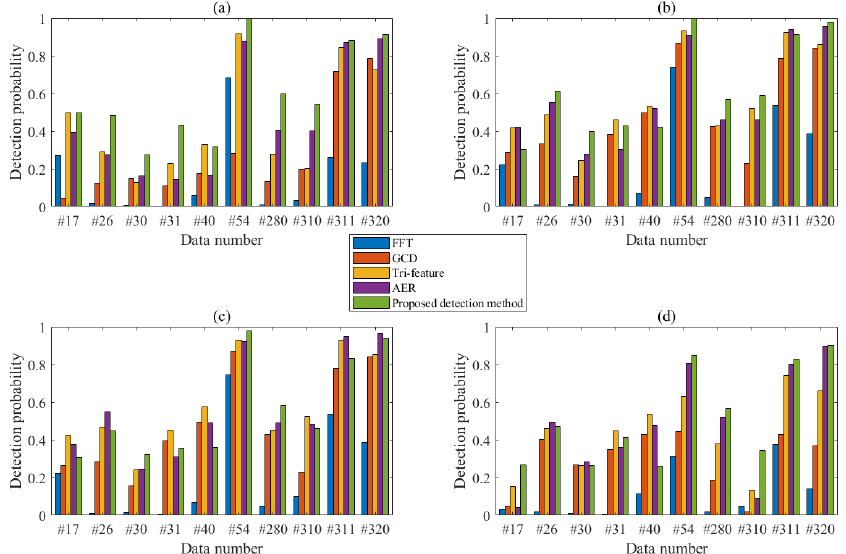
Figure 6. Contrasts of detection probabilities of five detection methods at (a) HH, (b) HV, (c) VH and (d) VV, when N = 512 and P fa = 10 − 3